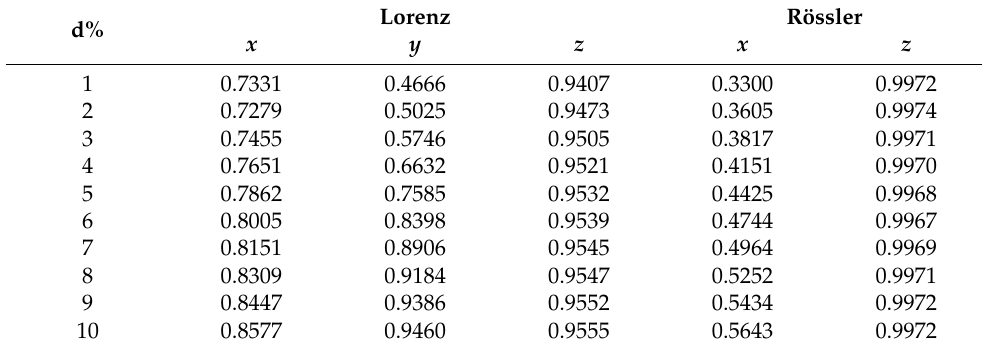
Table 2. Values for the quality observability index r